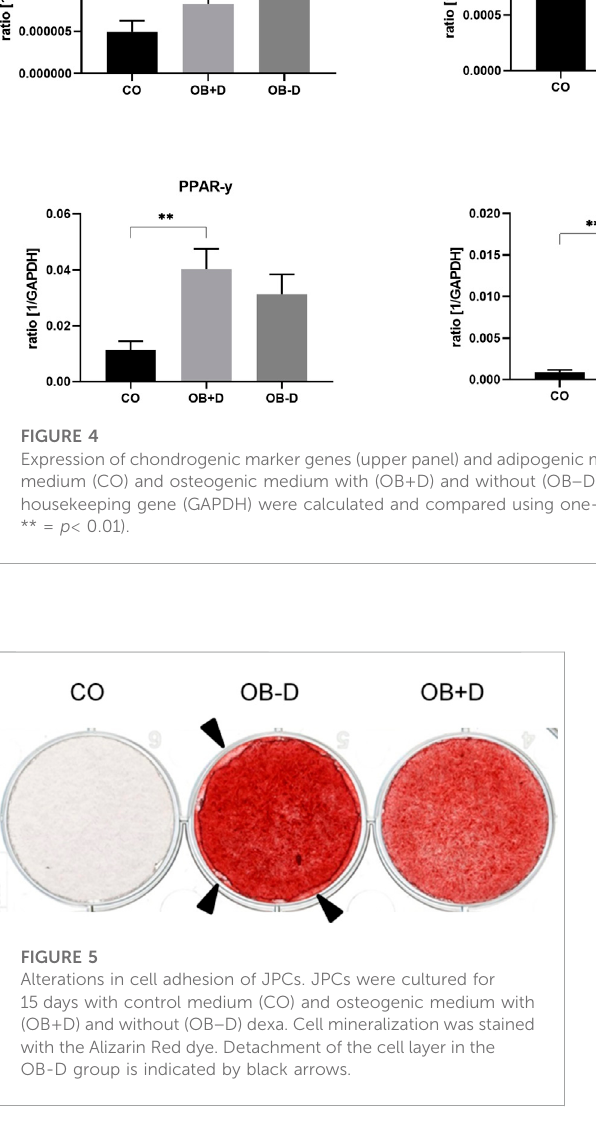
Frontiers in Cell and Developmental